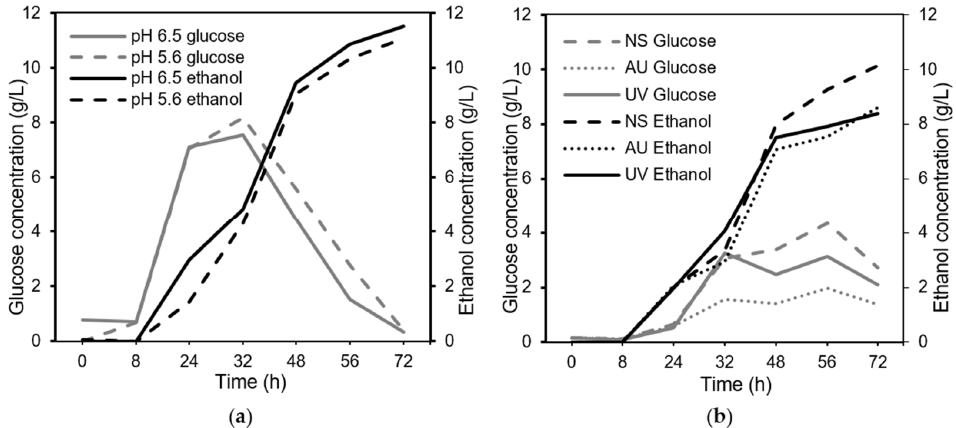
Figure 4. ( a ) The glucose and ethanol profiles are shown for different initial pH values with the 7.5% substrate concentration. ( b ) The glucose and ethanol profiles are shown for different sterilization methods with the added substrate under fed-batch conditions. The standard deviations for glucose and ethanol were 0.0–1.2% and 0.0–2.0%, respectively.